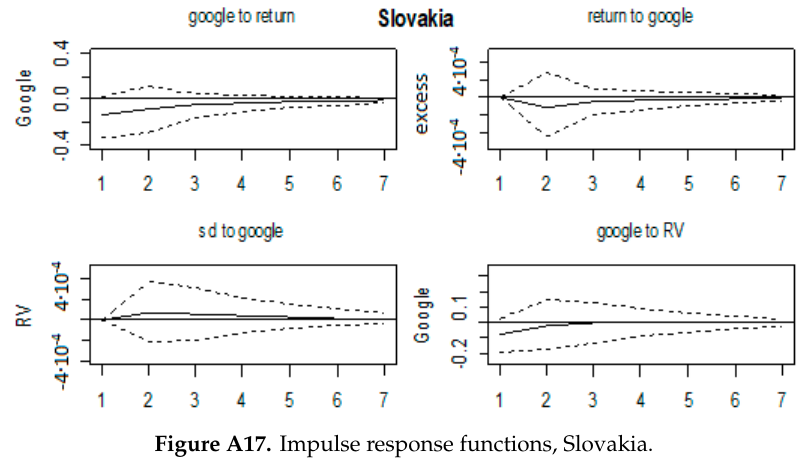
Figure A17. Impulse response functions, Slovakia.